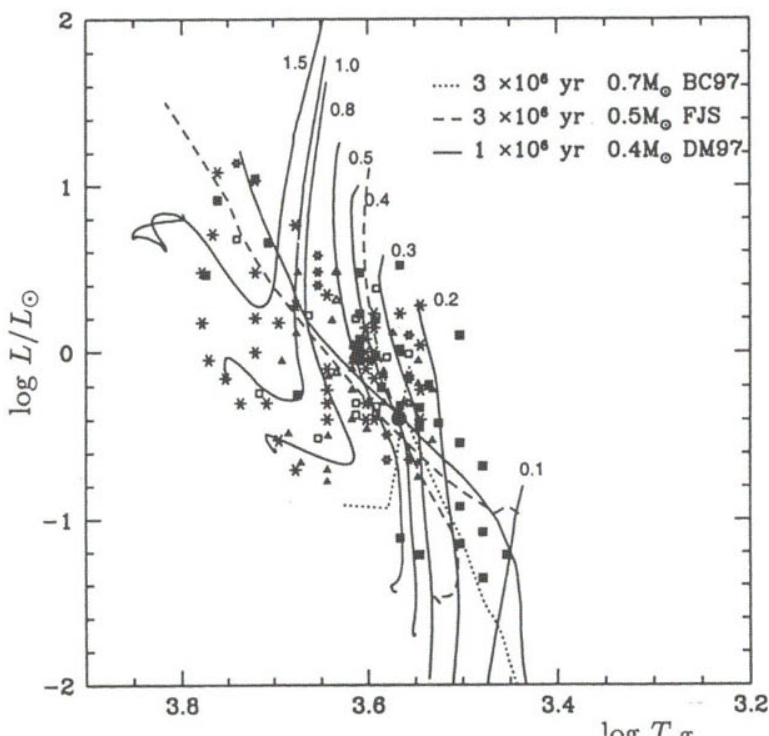
Fig. 1. Location of T Tauri stars taken from several observational sources are shown by different symbols. The pre-main-sequence (hereafter, pre-MS) evolutionary tracks by D'Antona & Mazzitelli (1997, DM97) for the labelled masses from 1.5 to 0.1 MQ are shown as continuous lines. Notice that some of the presumed T Tauri stars lie on the main sequence (!); probably, their distance determination is wrong. To determine age and mass of the star, represented by the full big dot, we can use the DM97 set of isochrones, getting 0.4 M© and ~10 6 yr, or the Swenson et al. (1994) isochrones and tracks (FJS, dashed) obtaining 0.5 MQ and ~2 X 10 6 yr, or the Chabrier & Baraffe (1997) isochrones (BC97) obtaining 0.4 MQ and 3 X 10 6 yr. Most of these differences are due to different treatment of convection employed in these three